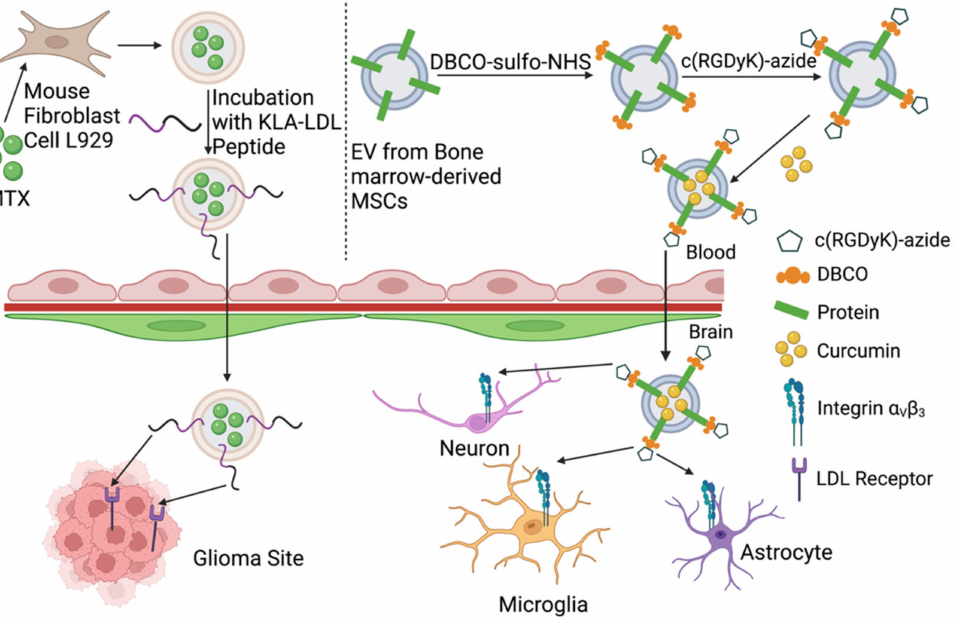
Figure 3. Schematic diagram of engineering of EVs during post isolation to endow EVs with a CNS targeting property. Ye et al. treated parent cells with the drug, Methotrexate (MTX), and fused a peptide onto EVs after isolation. Compared to free drugs, MTX primed EVs delivered more of the active drug across the BBB and reached the glioma site in the mice glioblastoma model. To grant EVs specific targeting capability in the ischemic site in the brain, Tian et al. modified the surface of EVs by click chemistry and loaded EVs with curcumin to treat ischemia, which demonstrated a better safety and efficacy than the control